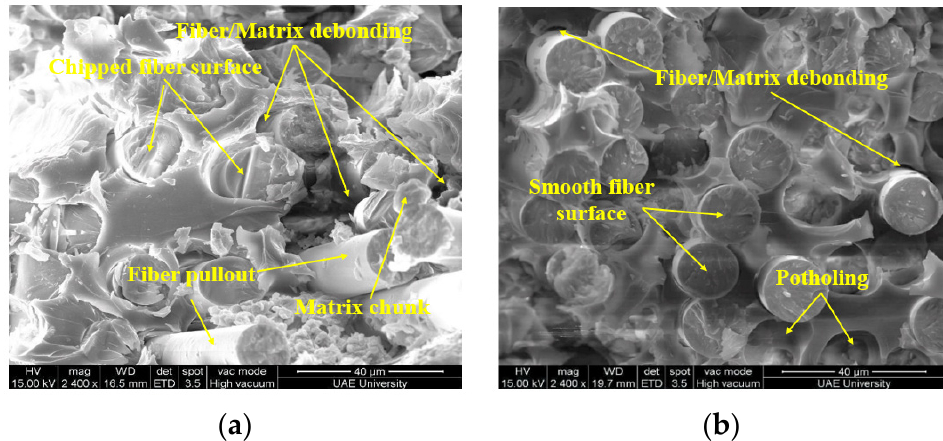
Figure 9. Failure surface of specimen immersed for the duration of 12 months at ( a ) 23 °C, and ( b ) 65 °C.